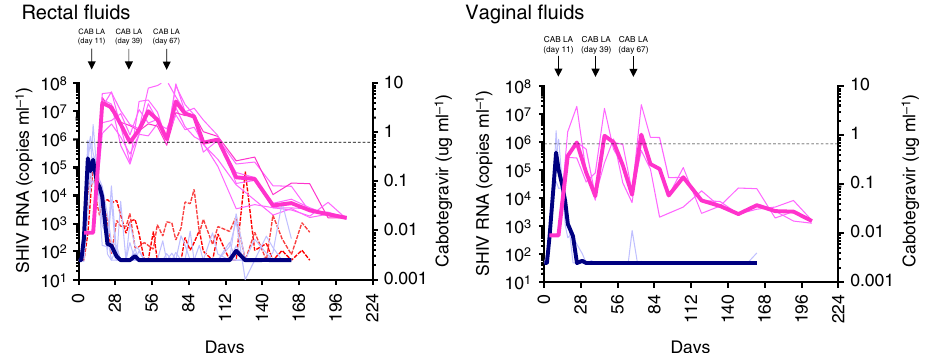
Fig. 2 Virus shedding and cabotegravir concentrations in rectal and vaginal fl uids. The dark magenta line represents the median concentration of cabotegravir and light magenta lines are the individual animals. The dark blue line represents median SHIV RNA levels seen in treated macaques and light blue lines are the individual animals. The two dotted red lines denote SHIV RNA levels in two male untreated controls. The horizontal dotted line indicates the 4xPA-IC 90 value (0.664 μ g/ml). The three cabotegravir long-acting (CAB LA) injections are shown on top of the fi gure. Source data are provided as a Source Data fi